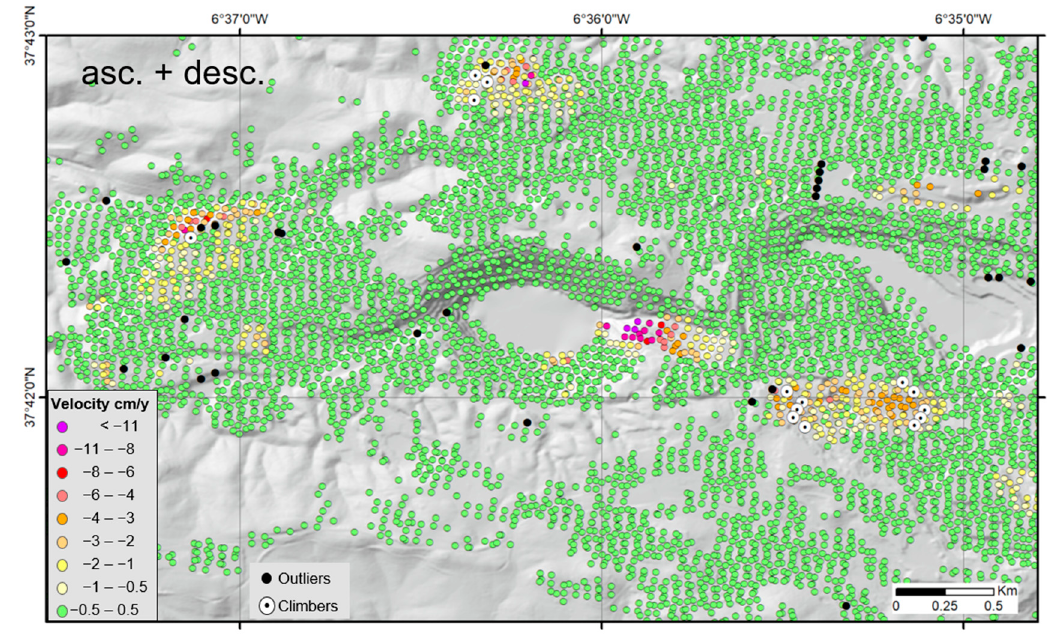
Figure 8. Displacement map integrating ascending and descending values. Velocity values quantify vertical displacement for slopes less than 13°, and displacement along the slope for greater slopes. Negative values mean downwards. Outsider values are in black and “climber” artifacts are the “vector out” symbols.